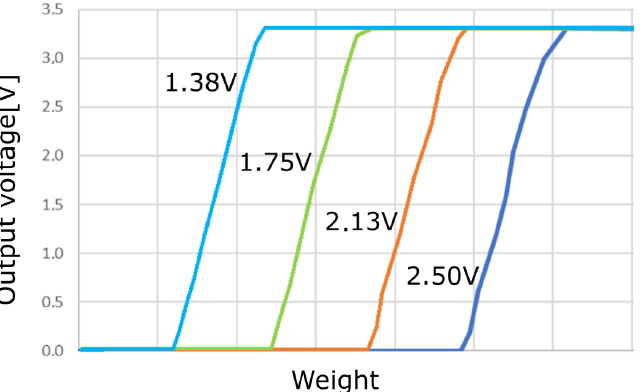
Figure 5. Simulation illustrating the calibrating procedure. Each curve is labelled by the related calibration voltage. The weight is swept over a meaningful range: however, the electrical simulation does not account for the actual pressure distribution through the layered mechanical structure but assumes a fixed conversion instead from weight to electrical conductance. For this reason, only a qualitative effect is shown here, with more quantitative details coming from the measurements